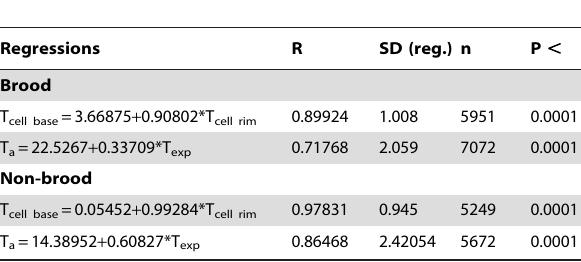
Table 1. Regressions between hive temperatures and experimental